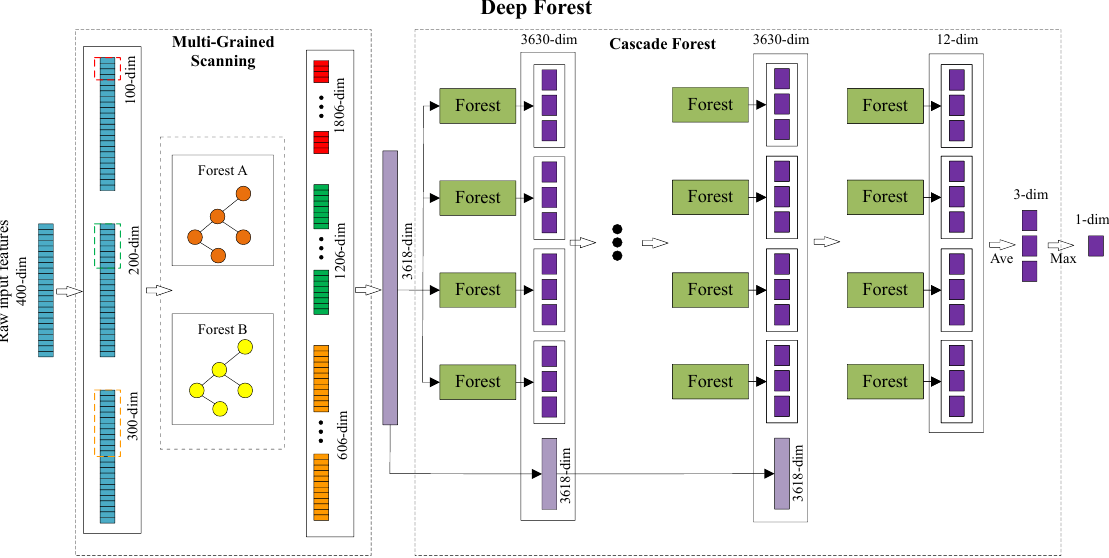
Figure 2. Fundamentals of deep forests. It mainly includes multi-grained scanning and cascade